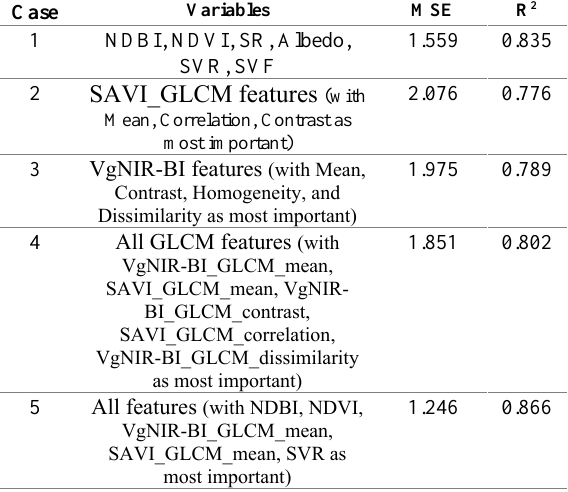
Table 2. Performance of the random forest regression